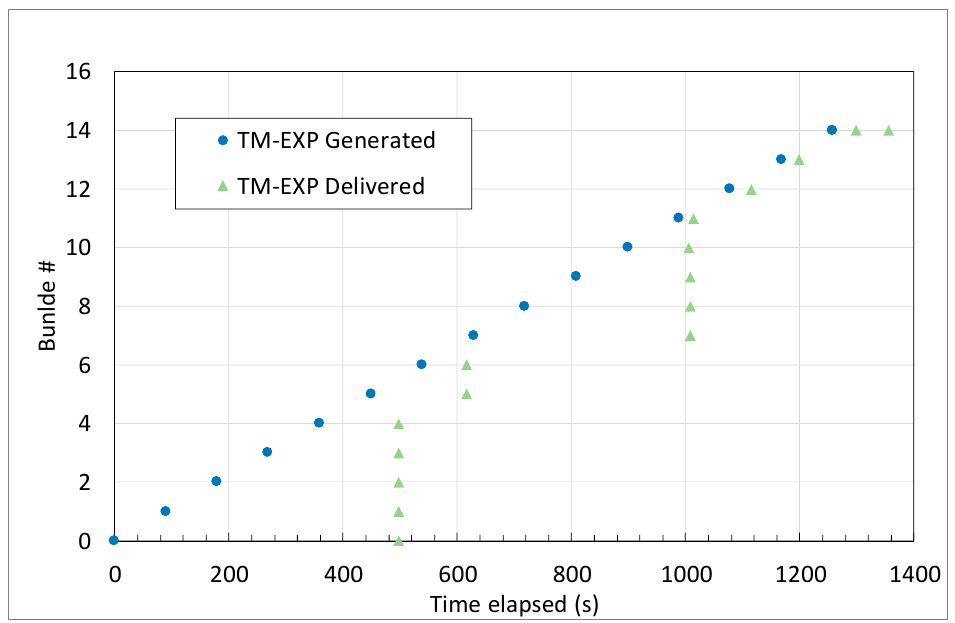
Figure 8. Urgent Telemetry data flow (TM-EXP, expedited priority) from Lander to ESA-MCC: time sequences of bundle generation and delivery.